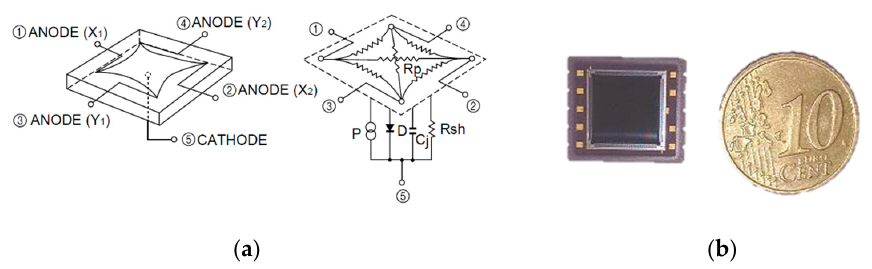
Figure 3. ( a ) Equivalent pin-cushion PSD circuit (image courtesy of Hamamatsu, obtained from PSD technical information); ( b ) Image of PSD S5991-01, Hamamatsu.